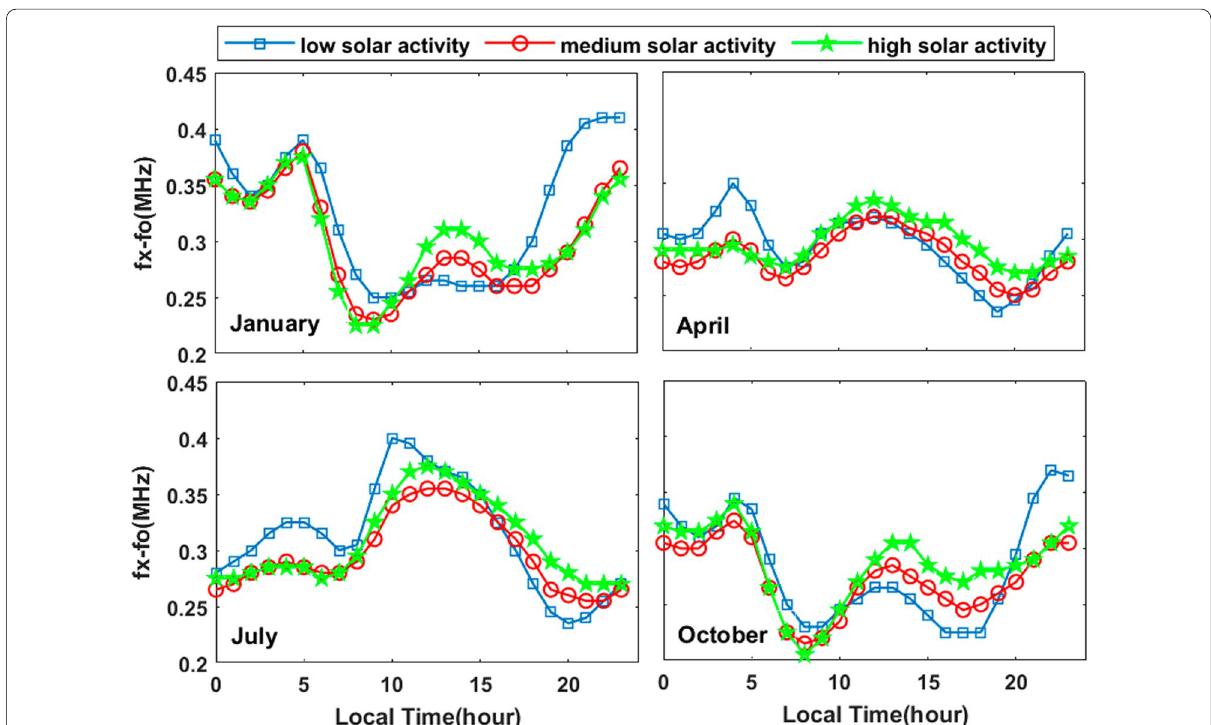
Fig. 13 Solar activity variability of the separation simulated using 3D ray-tracing method; blue line for low solar activity, red line for medium solar activity, and green line for high solar